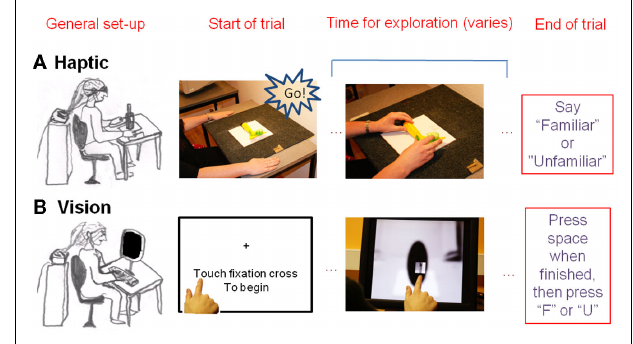
FIGURE 2 |Trial outlook in the (A) haptic and (B) visual object identification